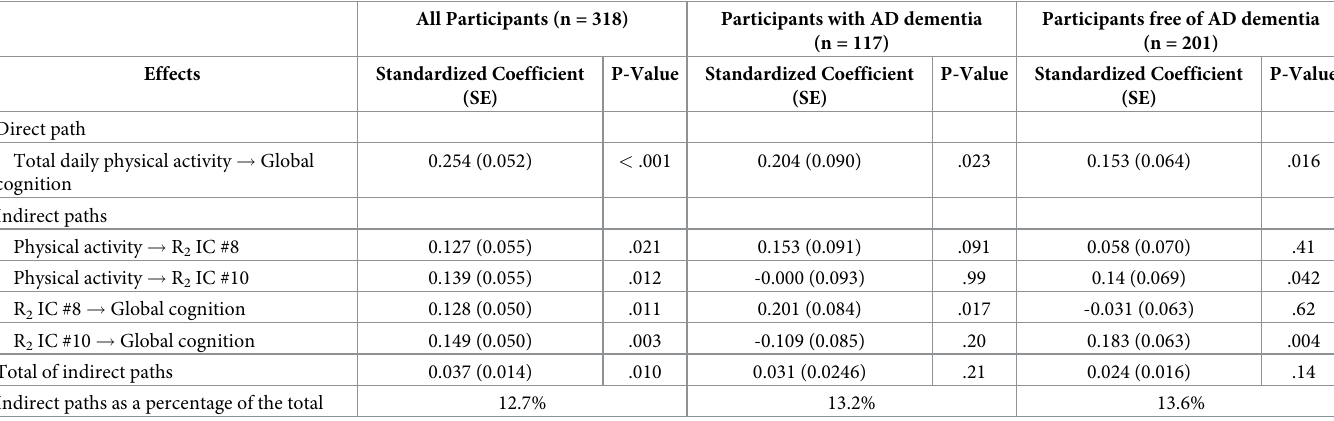
Table 2. Mediation of the relation between physical activity and global cognition by brain tissue microstructure, in participants with and without AD dementia. All Participants (n = 318) Participants with AD dementia (n =